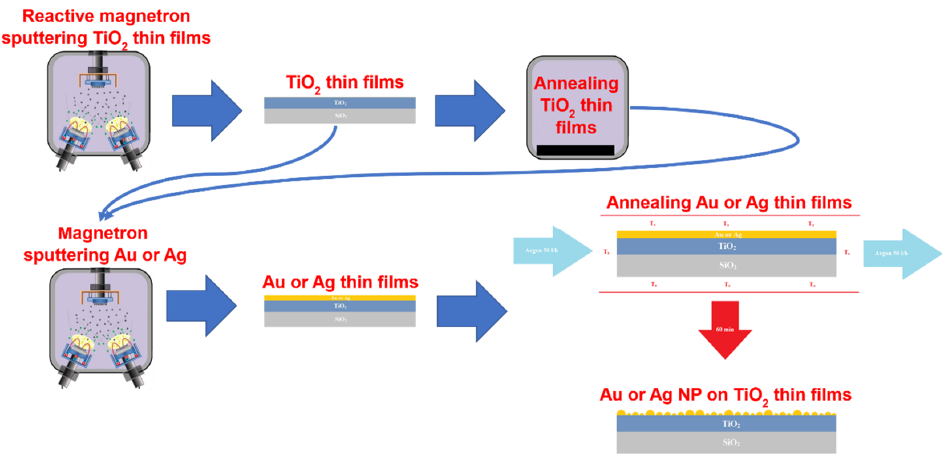
Figure 1. Formation of NP/TiO 2 structures.